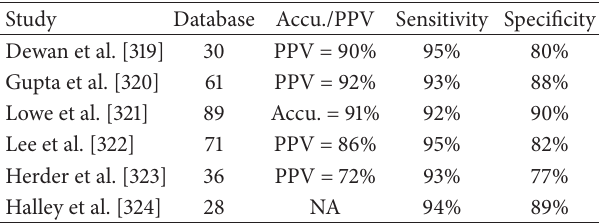
Table 10: Evaluation of nodule malignancy in PET.